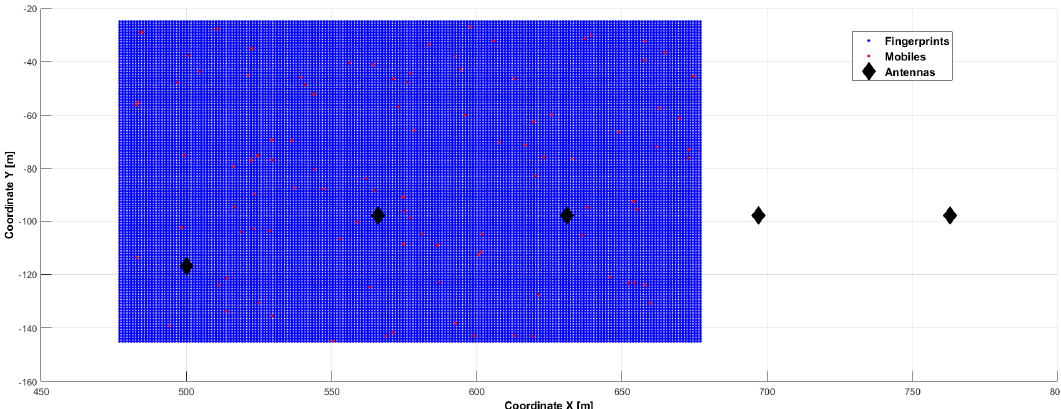
Figure 15. 2D view of Terminal 4 at Adolfo-Suarez Madrid-Barajas International Airport simulation